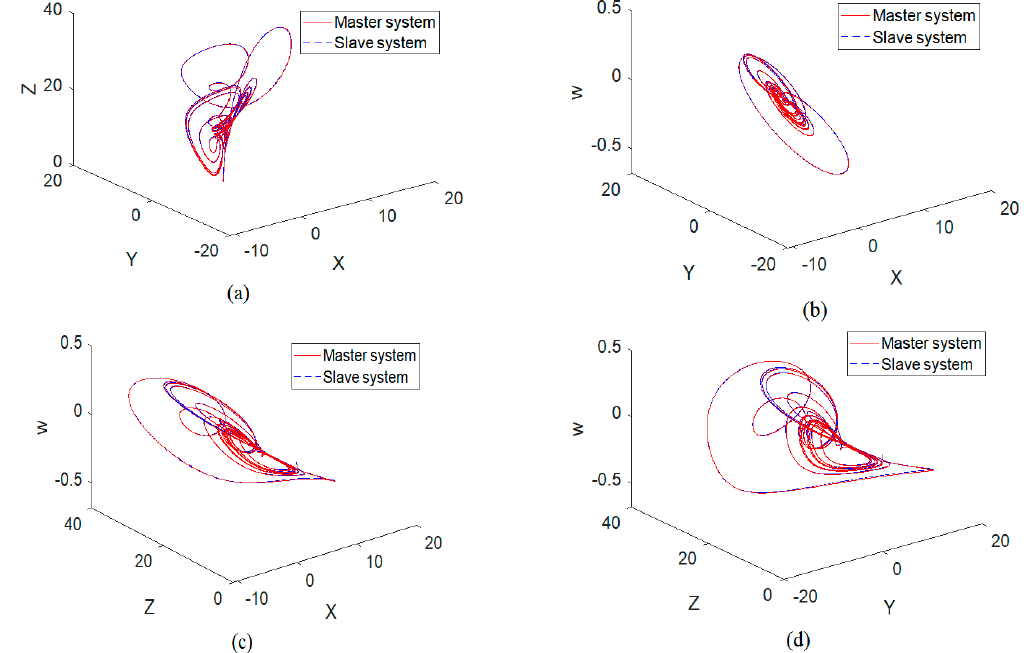
Figure 12. Synchronization of the 4D Lorenz–Stenflo chaotic system using the SRIT2PC for Case 2: ( a ) x–y–z space, ( b ) x–y–w space, ( c ) x–z–w space, and ( d ) y–z–w space.